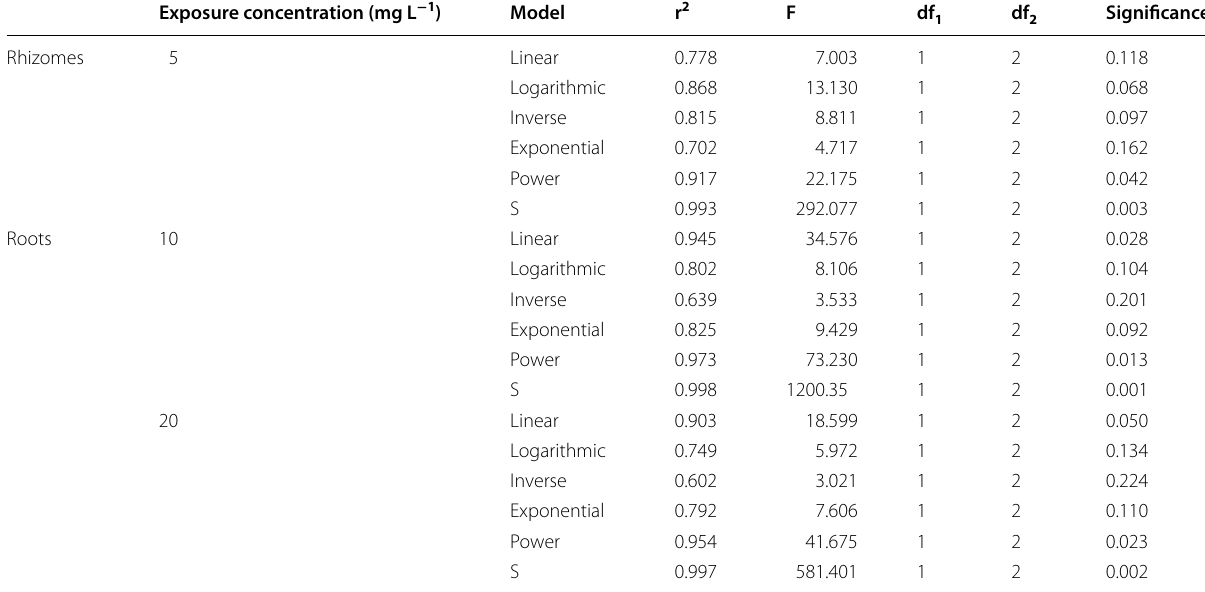
The exposure concentrations of 5, 10 and 20 mg L − 1 correspond to 44.48, 88.95 and 177.94 μM, respectively